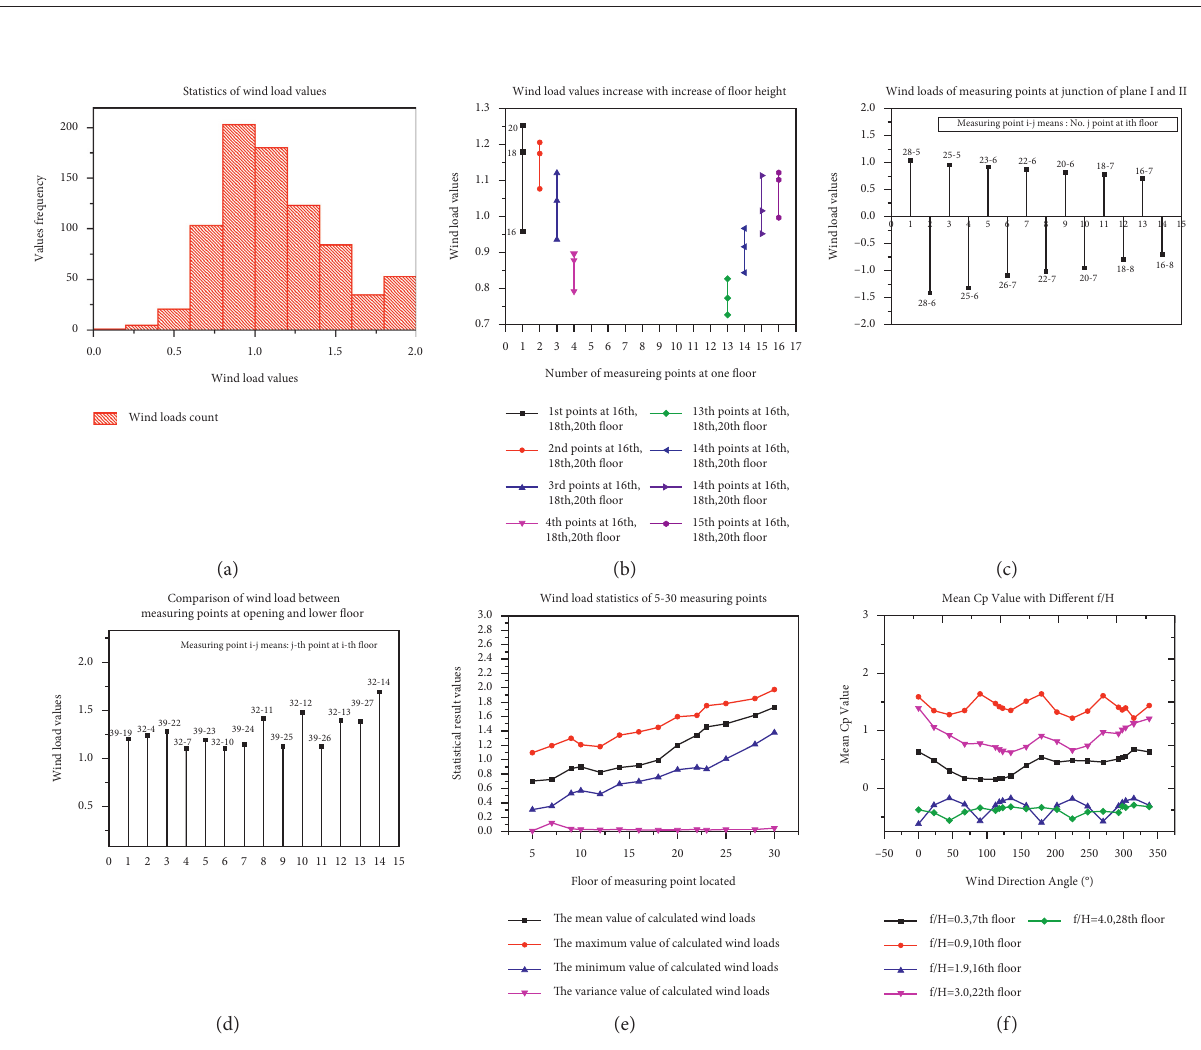
Figure 13: Wind load calculation results